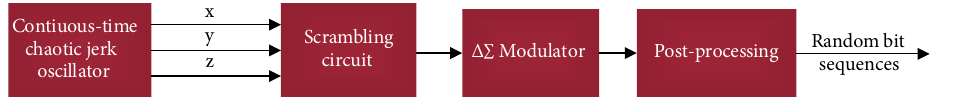
Figure 4: Block diagram of the TRBG with sigma-delta modulation of chaotic jerk signals proposed by Wannaboon et al